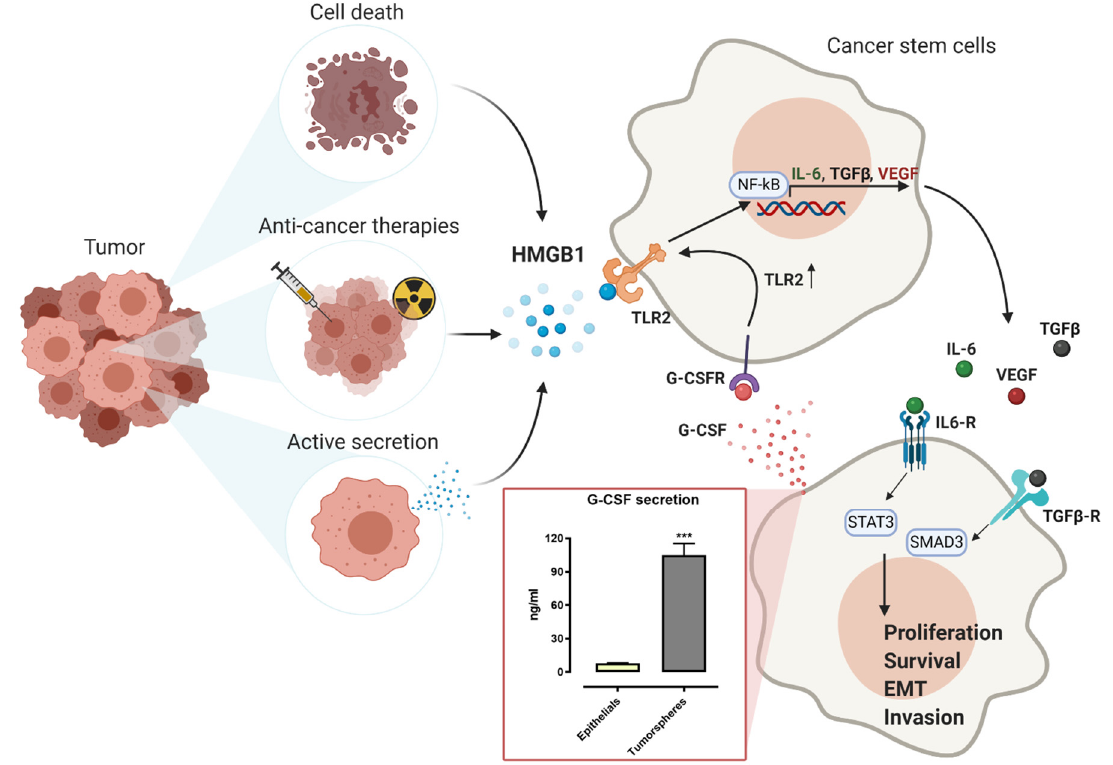
Figure 3. The high-mobility group box protein 1 (HMGB1)/TLR2 axis promotes cancer stem cell (CSC) self-renewal, proliferation, and invasion. TLR2 is expressed on many tumors, in particular on CSCs that release granulocyte colony-stimulating factor (G-CSF), as demonstrated by ELISA analysis of G-CSF production in TUBO epithelial breast cancer cells or their CSC-enriched tumorspheres (the graph shows results from three independent experiments. ***, p < 0.001, Student’s t test). In turn, G-CSF is an inducer of TLR2 expression. Cancer cell death and aggressive therapies, such as radio- and chemotherapies, lead to the release of HMGB1 in the extracellular space. In addition, HMGB1 can be also actively secreted by cancer cells. TLR2 binds HMBG1 and activates the transcription of pro-tumoral factors, such as IL-6, TGF- β , and VEGF, which act in an autocrine and paracrine manner, leading to cancer cell survival, proliferation, epithelial to mesenchymal transition (EMT), and invasion. All arrows indicate activation or secretion. Created with BioRender.com.